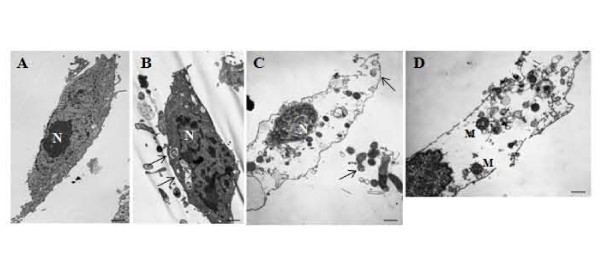
PLD apparently induces host cell damage by necrosis. Representative transmission electron micrographs of HeLa cells, (A) uninoculated, or inoculated with (B) A. haemolyticum pld mutant or (C, D) A. haemolyticum wild type using a standard invasion assay. Arrows indicate bacteria, N and M indicate the nucleus and mitochondria, respectively. The bars on the lower right indicates ~1 μm.